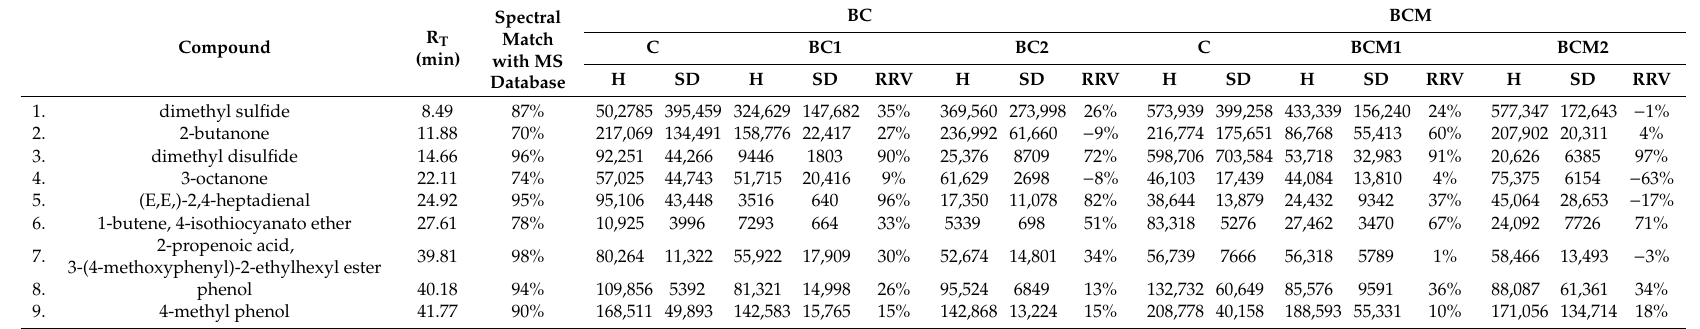
Table 6. E ff ect of investigated treatments on tentatively identified volatile organic compounds (mean, n =